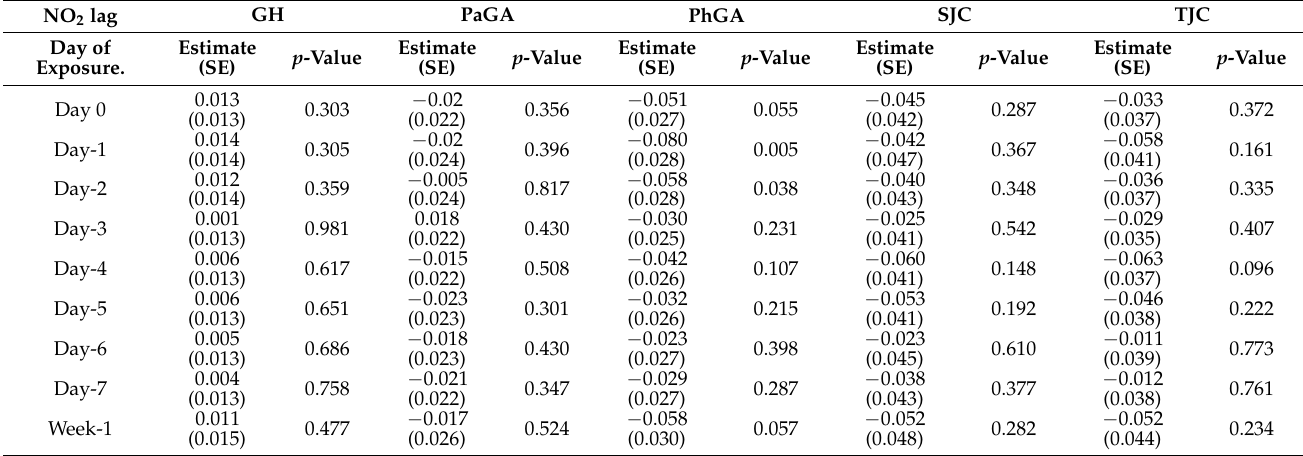
Table A7. Associations between NO 2 short-term exposure and RA disease activity.